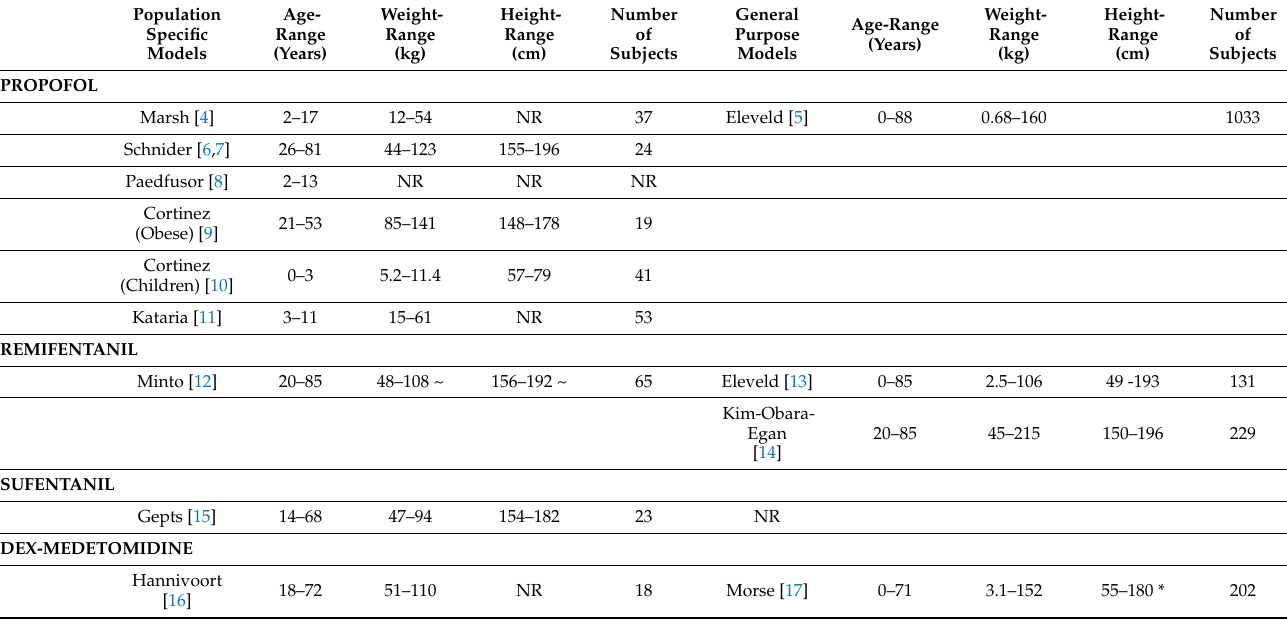
Table 1. Demographic ranges of the respective original study populations for developing the PKPD models applied in contemporary commercialized target controlled infusion systems. (non- exhaustive